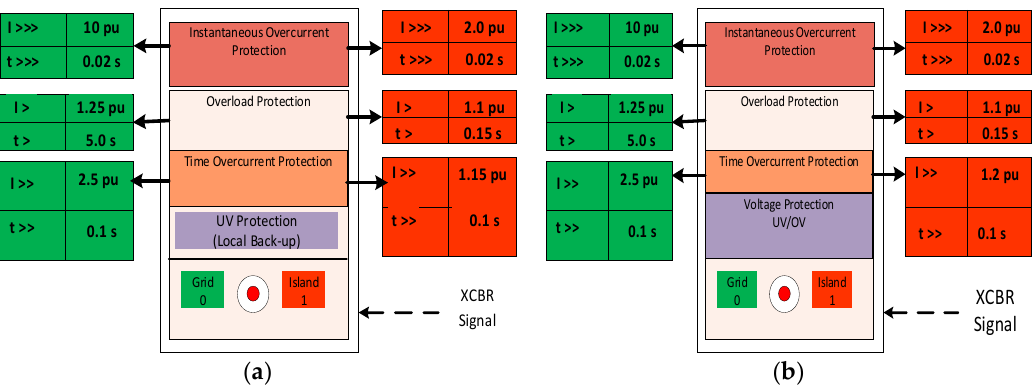
Figure 3. Adaptive definite time overcurrent (DTOC) relays with two preplanned setting groups: ( a ) for lines with local undervoltage (UV) backup protection and ( b ) for loads with local voltage protection (UV/over-voltage (OV)).